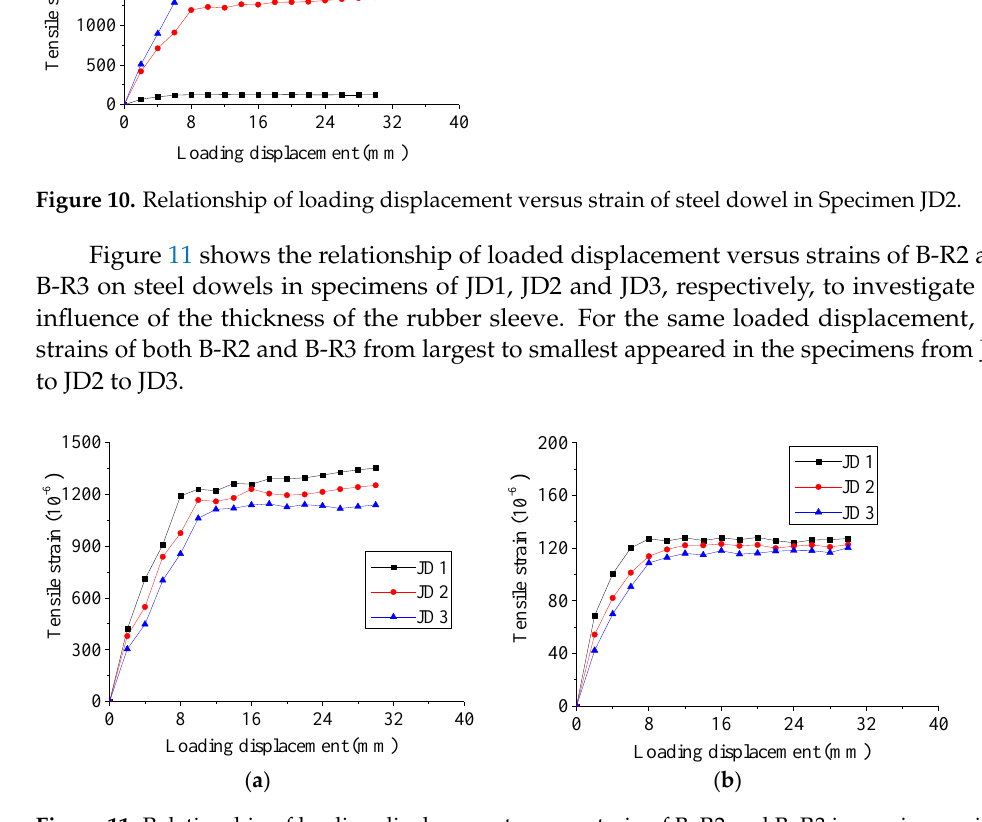
Figure 11. Relationship of loading displacement versus strain of B–R2 and B–R3 in specimen with a variation of thickness of rubber sleeve; ( a ) B–R2; ( b ) B-R3.